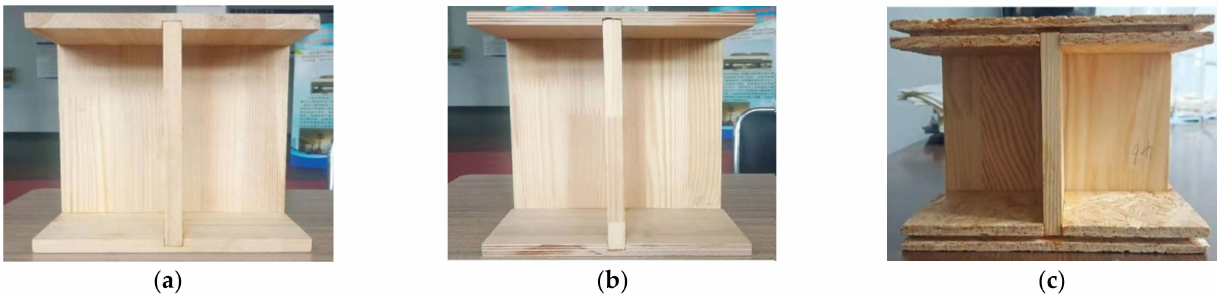
Figure 7. Specimens of interlocking grid structure. ( a ) Larch + Larch; ( b ) Plywood + Larch; ( c ) OSB +